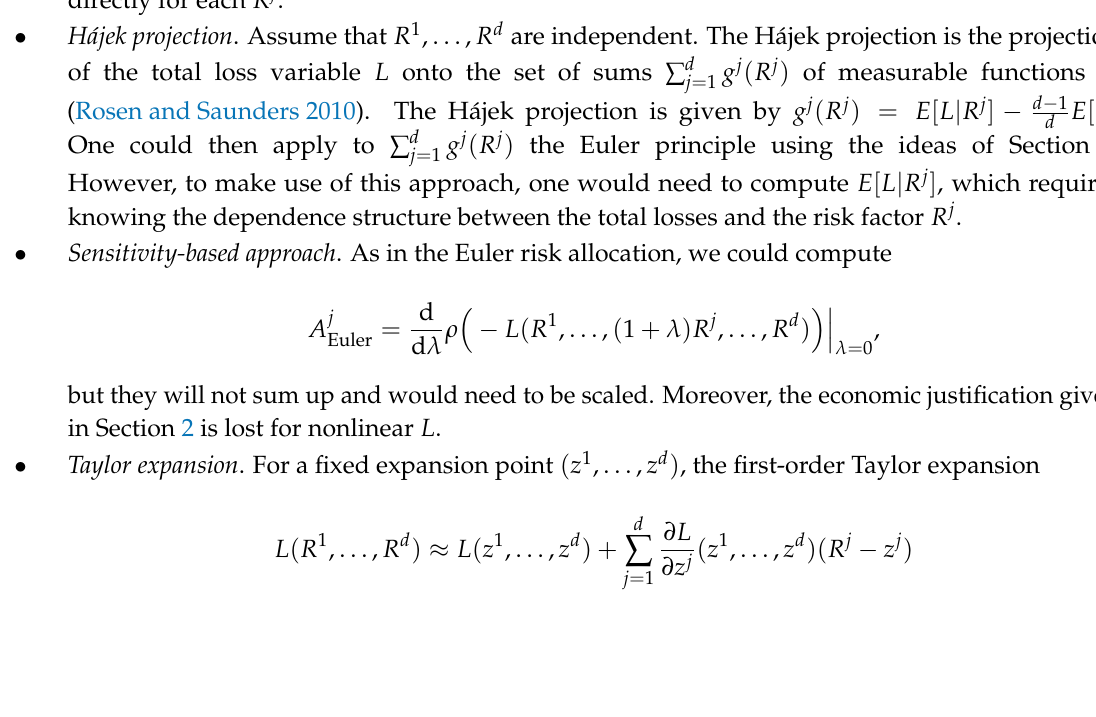
) ) ≥ VaR α ( f (( R i i T